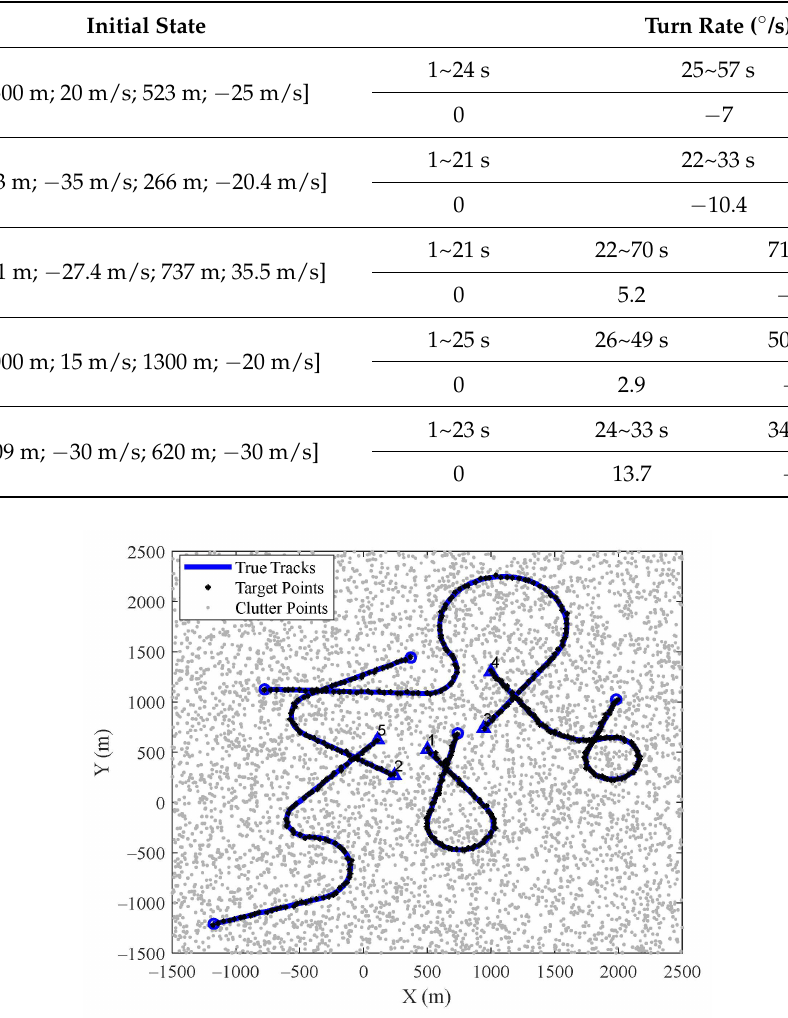
Figure 8. Simulation scenario. ( (cid:52) —start position,